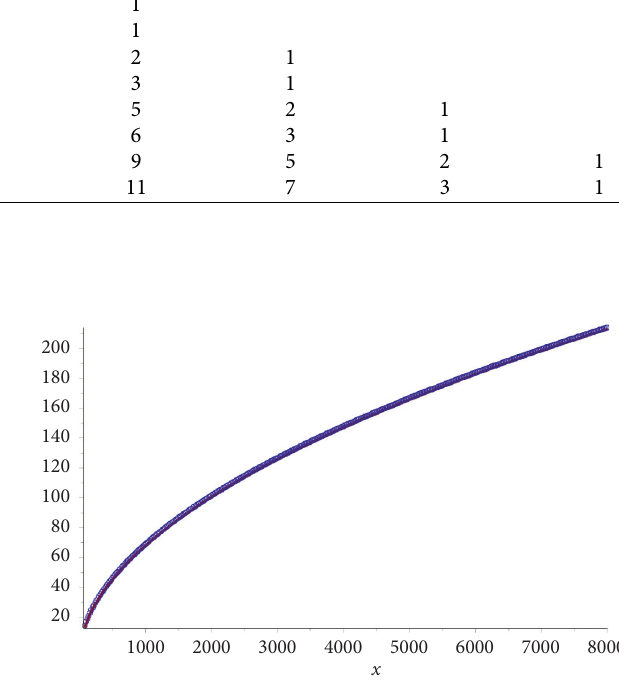
Figure 1: The graph of the data ( n, ln h ( n )) .